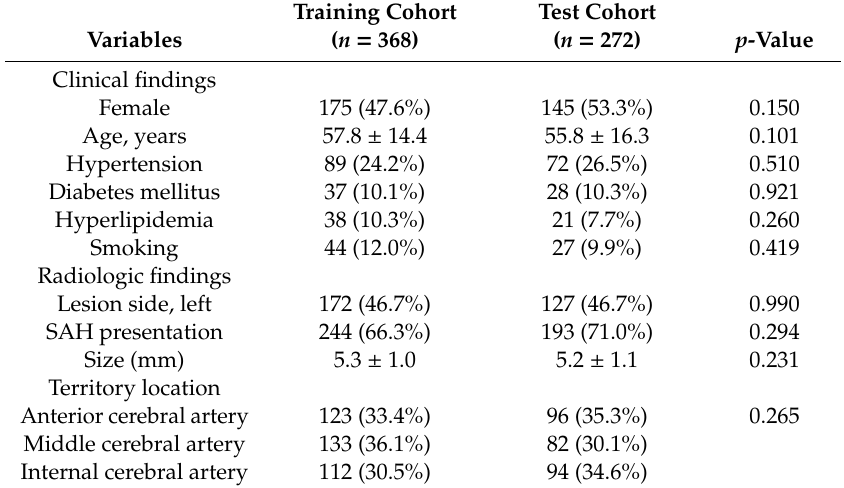
Table 1. Comparison of clinical and radiologic characteristics between the training and test cohorts.